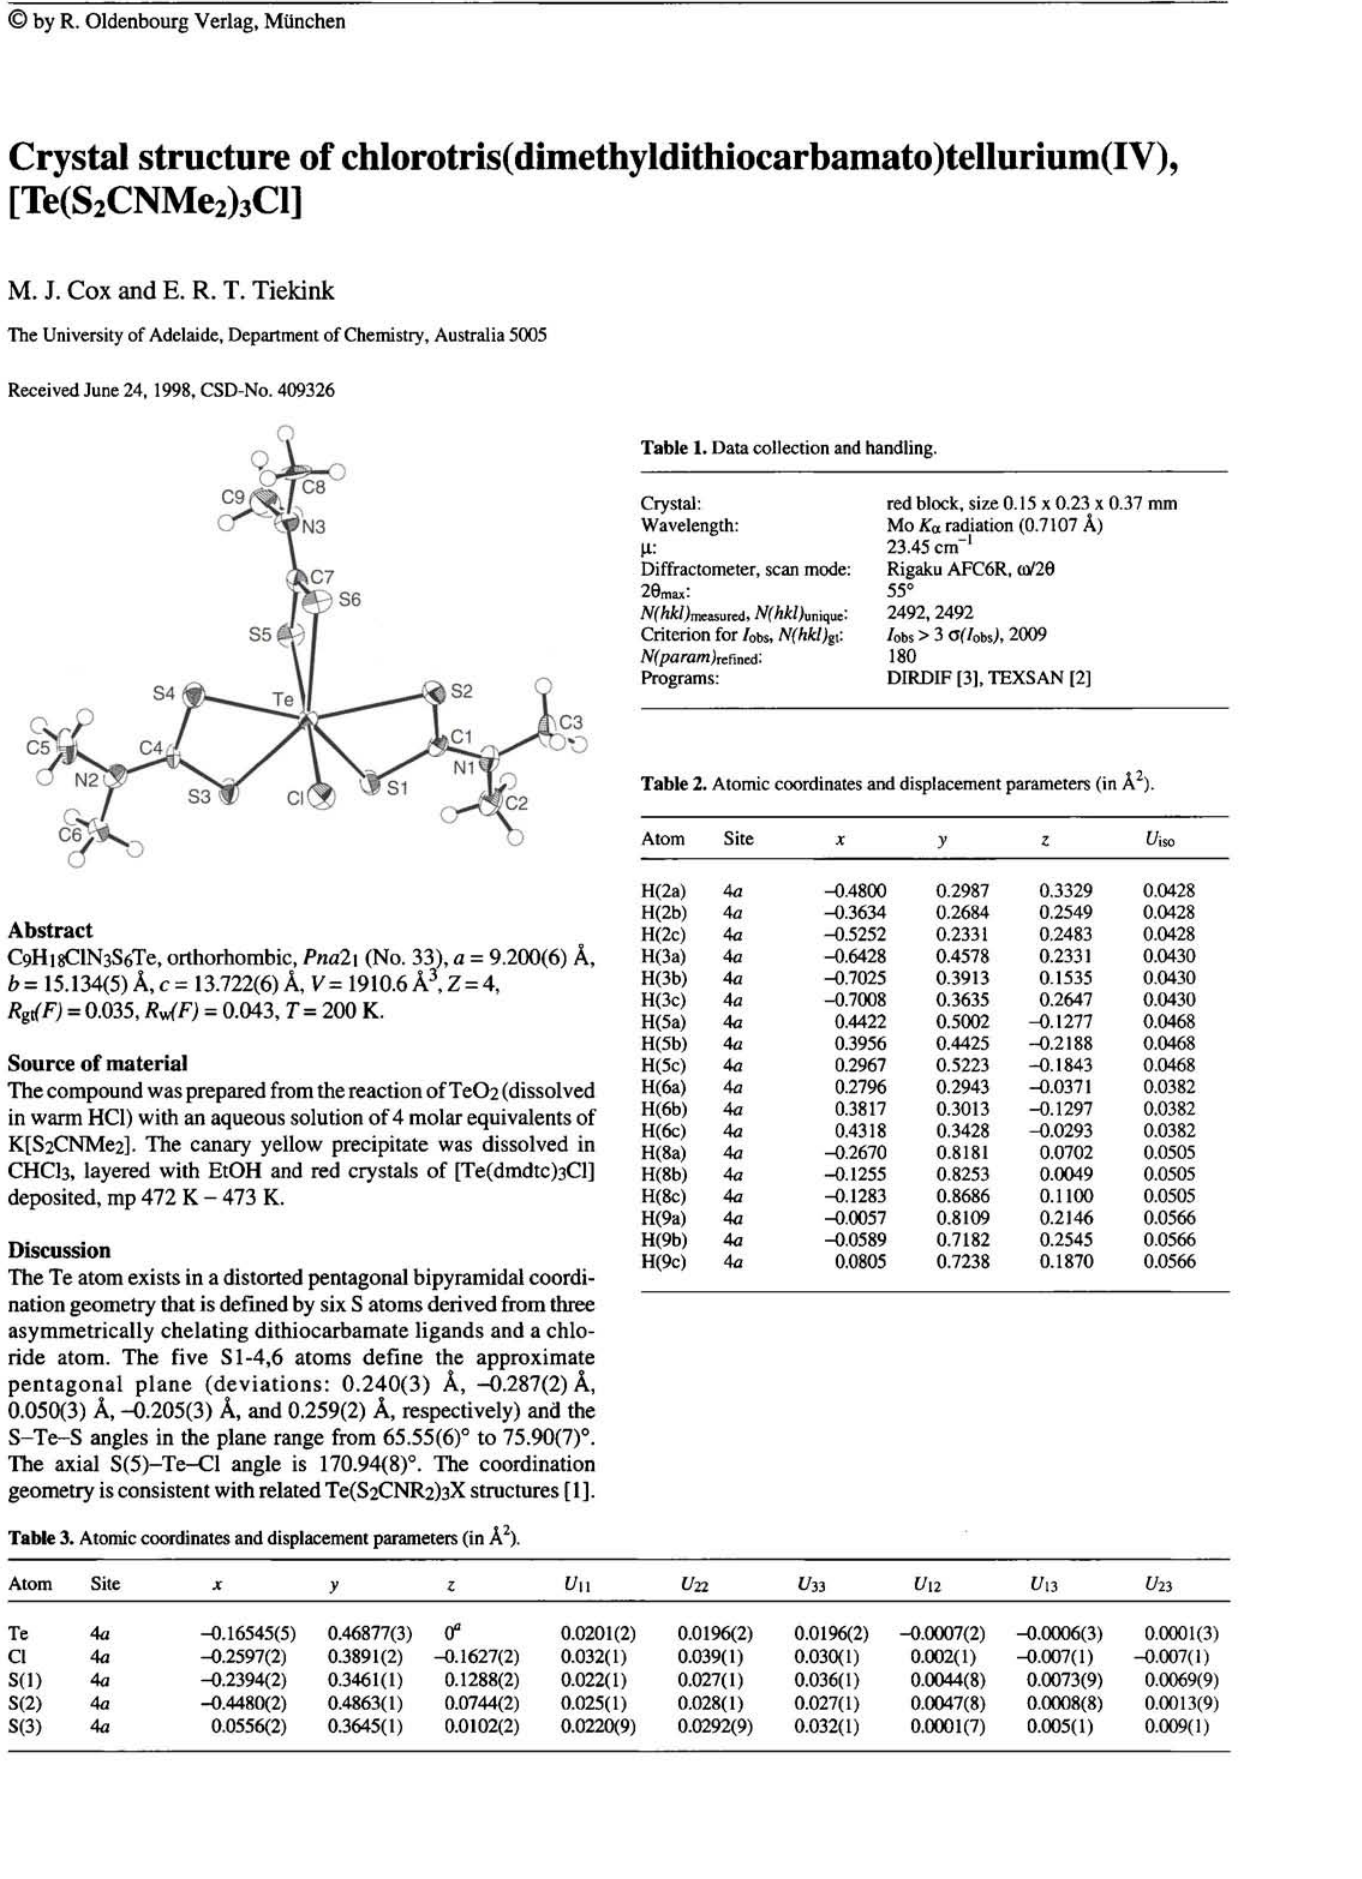
Table 1. Data collection and handling. Crystal: